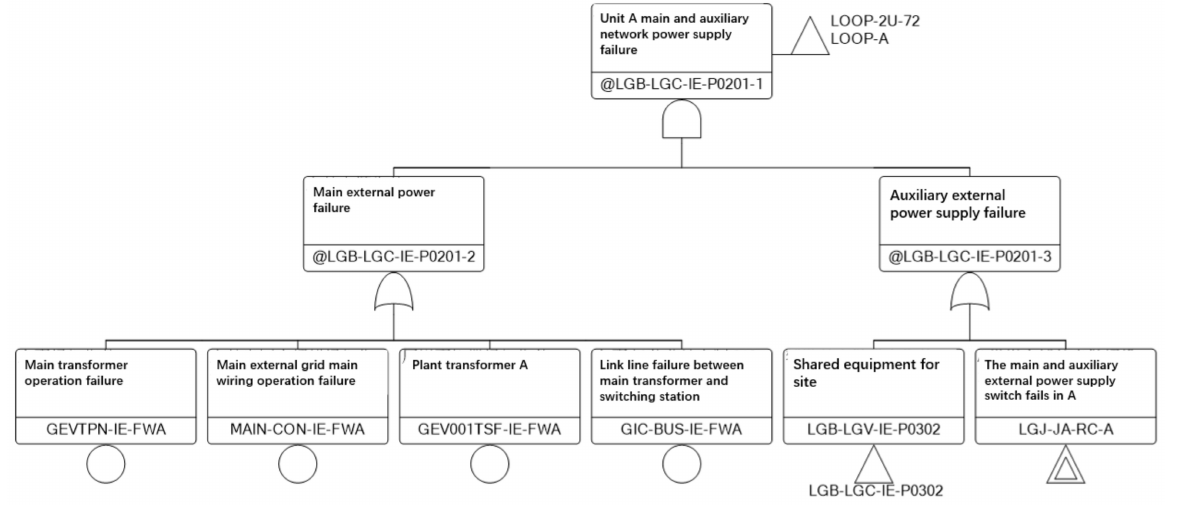
Figure 2. Fault tree of main and auxiliary external network power supply